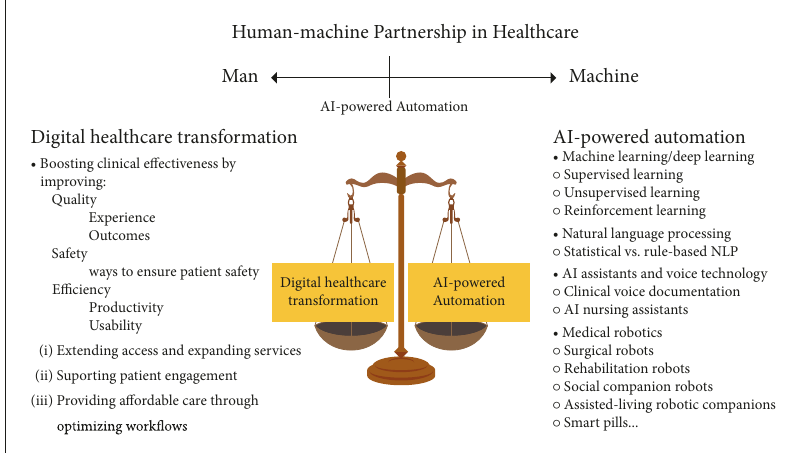
Figure 1: Relationship of human-made and machine-made treatment facilities